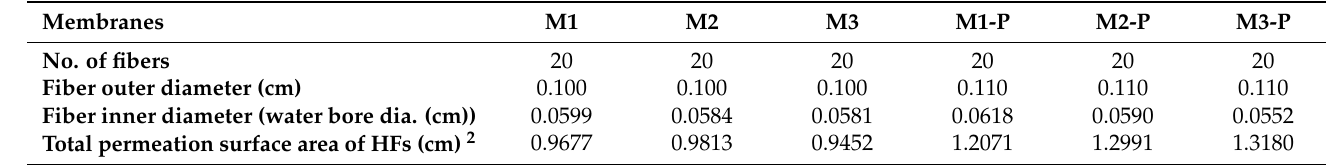
Figure 1. Schematic diagram of hollow fiber spinning system: (1) nitrogen cylinder; (2) dope reservoir; (3) gear pump; (4) on-line filter, 7 mm; (4) syringe pump; (5) spinneret; (6) forced convective tube; (7) roller; (8) wind-up drum; (9) refrigeration/heating unit; (10) coagulation bath; (11) washing/treatment bath; (12) wind-up bath; (13) schematic spinneret [5]. Table 2. Geometrical characteristics of HFs and